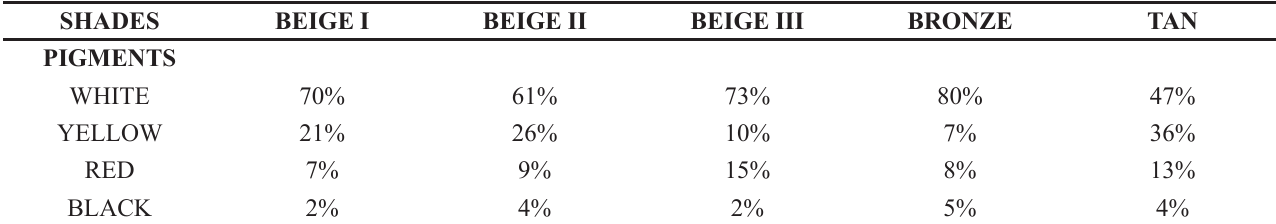
TABLE V - Proportions of mixed pigments and the resulting different shades SHADES BEIGE I